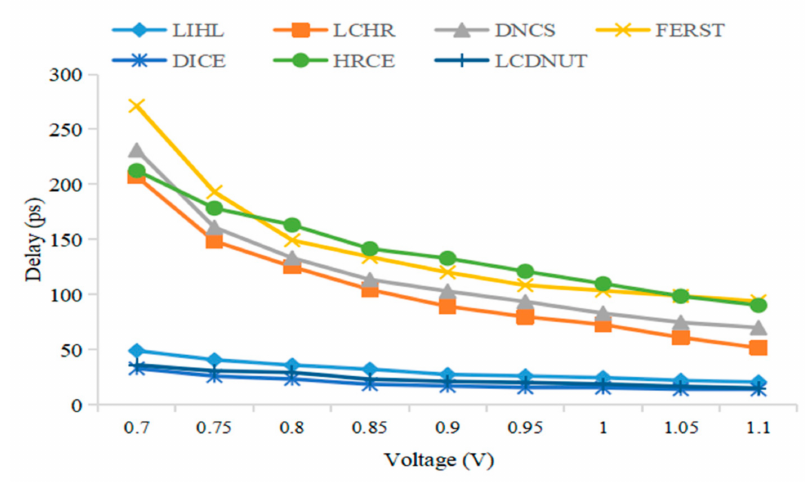
Figure 15. Delay comparison of various latch designs under different voltages.